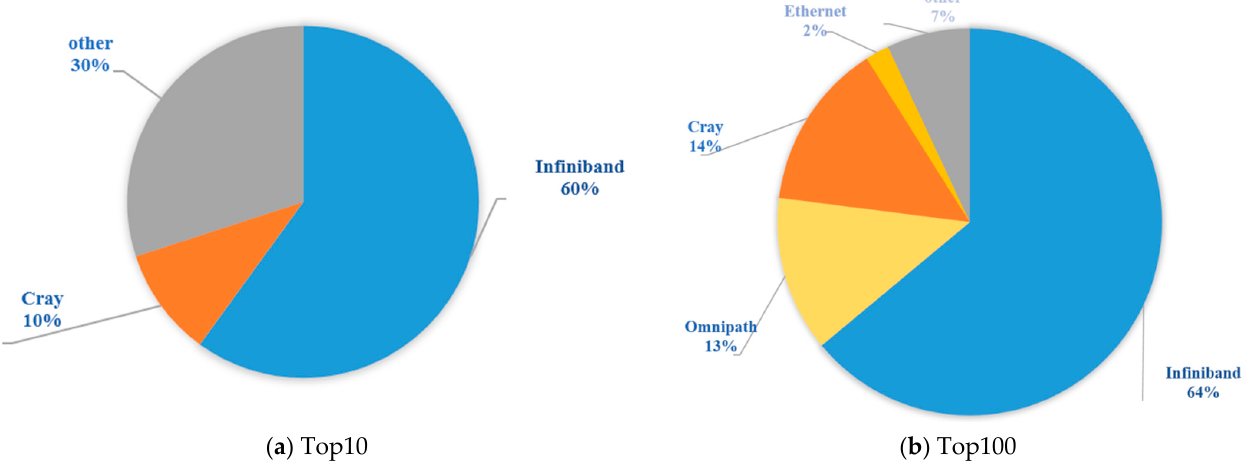
Figure 1. Distribution map of ICNs in the Top10 and the Top100 as of November 2021.